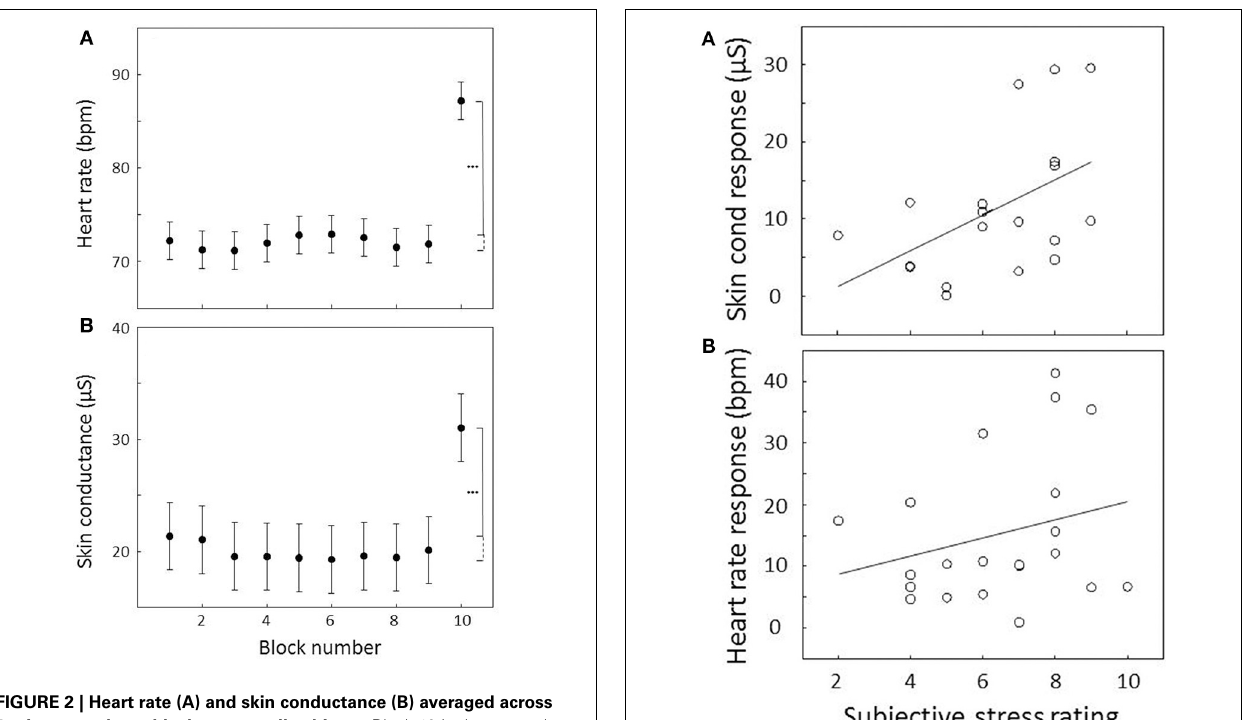
false alarms occurring during the first 20 s of the experiment were not counted, this resulted in a 60% reduction of false alarms as indicated in the table. The last two columns show the mean and median detection times (DTs), indicating the time between